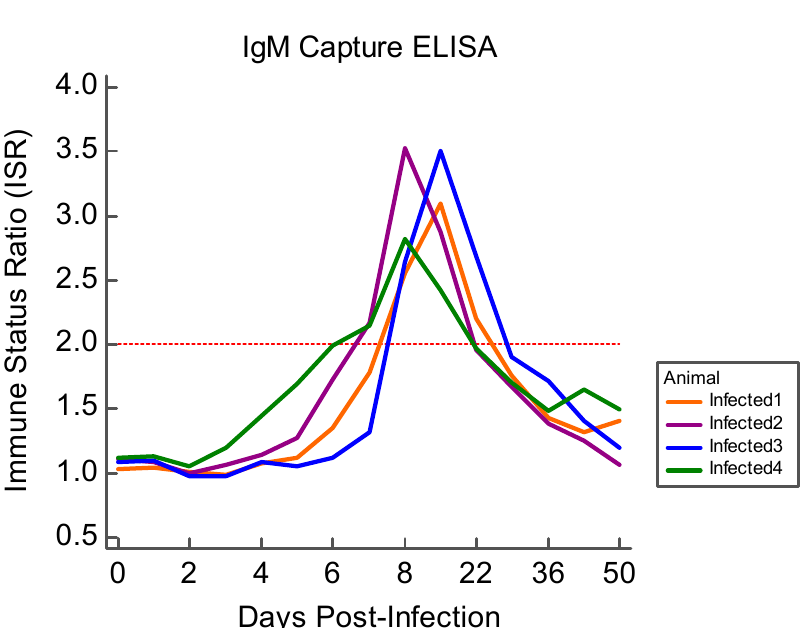
Figure 4. Results of the ovine specific ZIKV IgM capture ELISA for all infected animals. IgM was measured daily for the first two weeks PI, then weekly thereafter; an ISR greater than 2.0 ( red dotted line ) was considered “positive.”